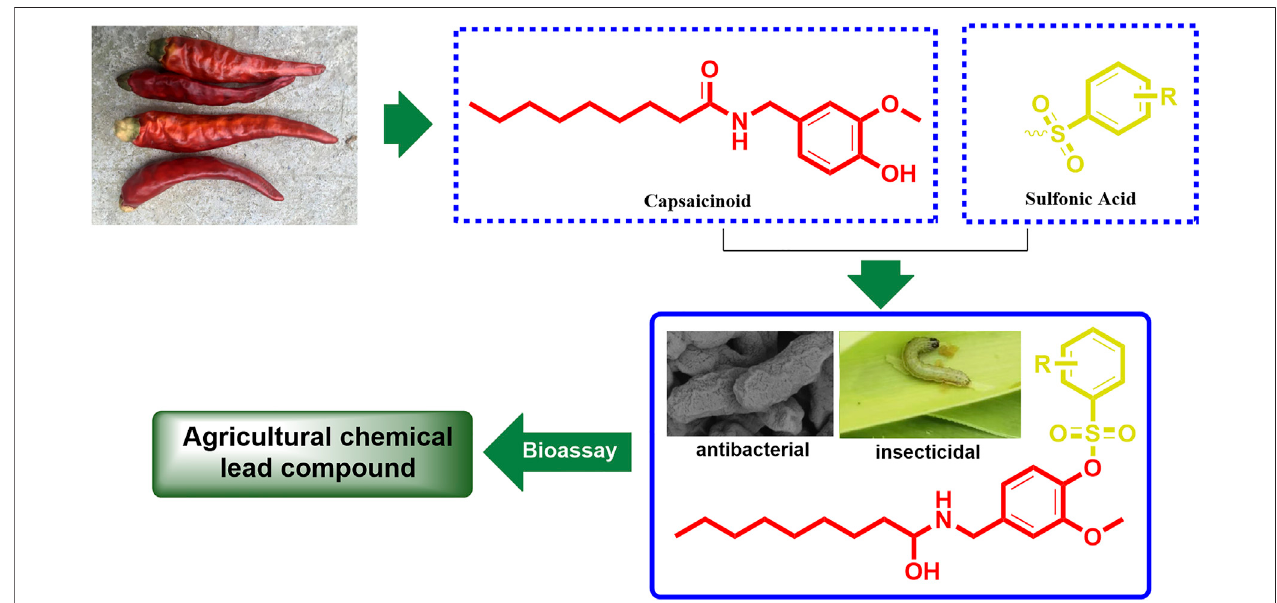
FIGURE 1 | The overall design idea of